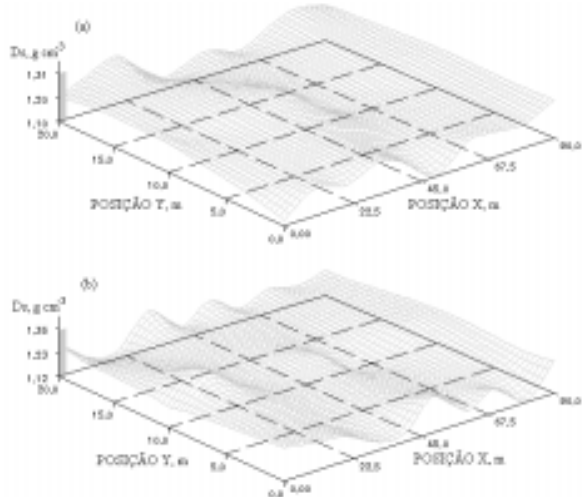
Figura 3. Superfícies de densidade do solo ( Ds ) para os piquetes em sistema de pastejo contínuo: (a) com adubação de manutenção (Cc) e (b) sem adubação de manutenção